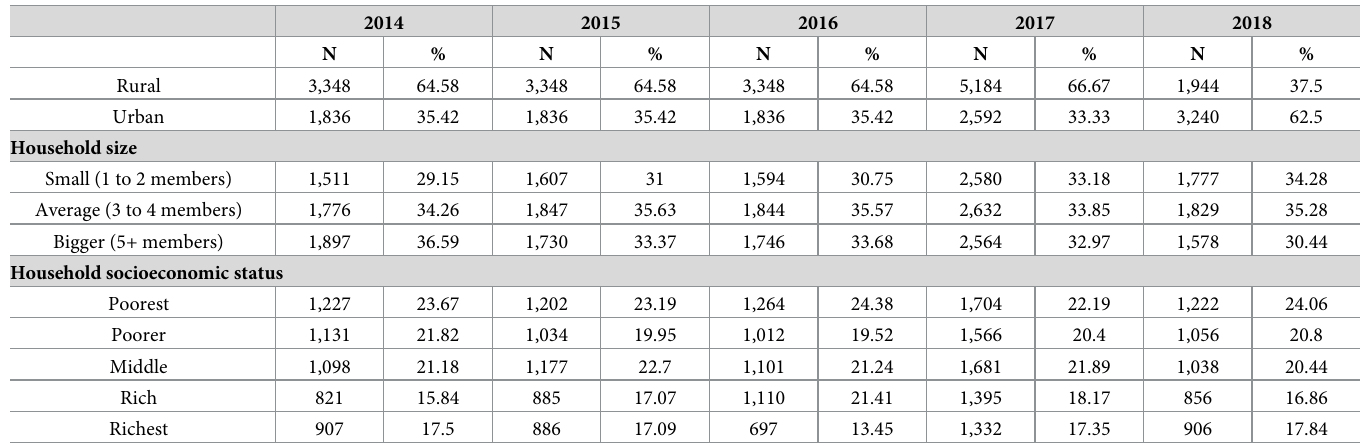
over a tenth of the surveyed households had a member with access to private health insurance. Less than two percent of surveyed households had a member in the military, while approxi- mately three percent had a child who qualified as a part of the children’s group [8]. Health care costs–OOP payments Table 2 shows the average and median household OOP payments for outpatient, inpatient, and total health care costs from 2014 to 2018 in constant 2018 Armenian Drams (AMD). Within each year, the average and median OOP payments for outpatient costs were higher than those for inpatient care. Overall, the mean OOP payments per household increased sig-